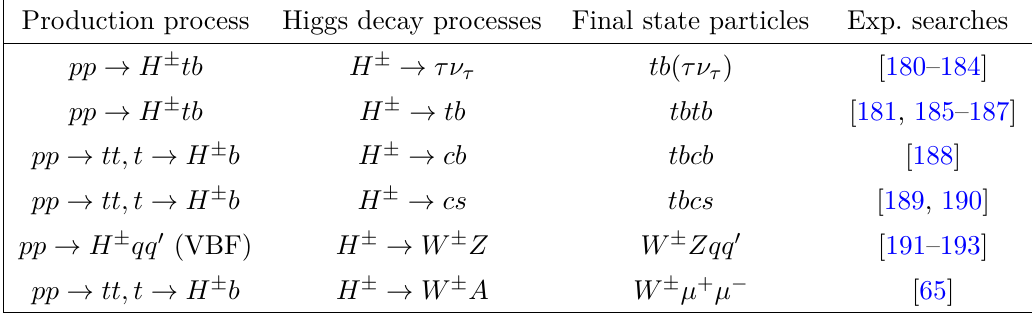
quark, if kinematically